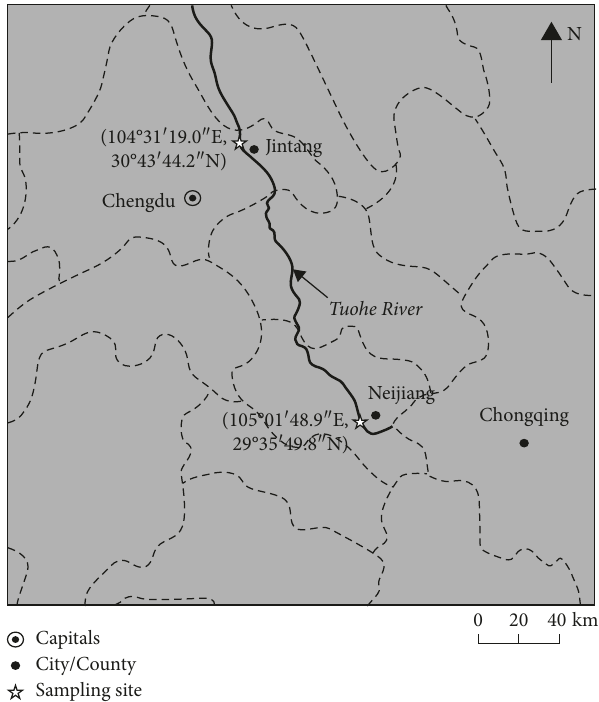
Figure 1: Sampling sites at Jintang (upstream) and Neijiang (downstream) on the Tuohe